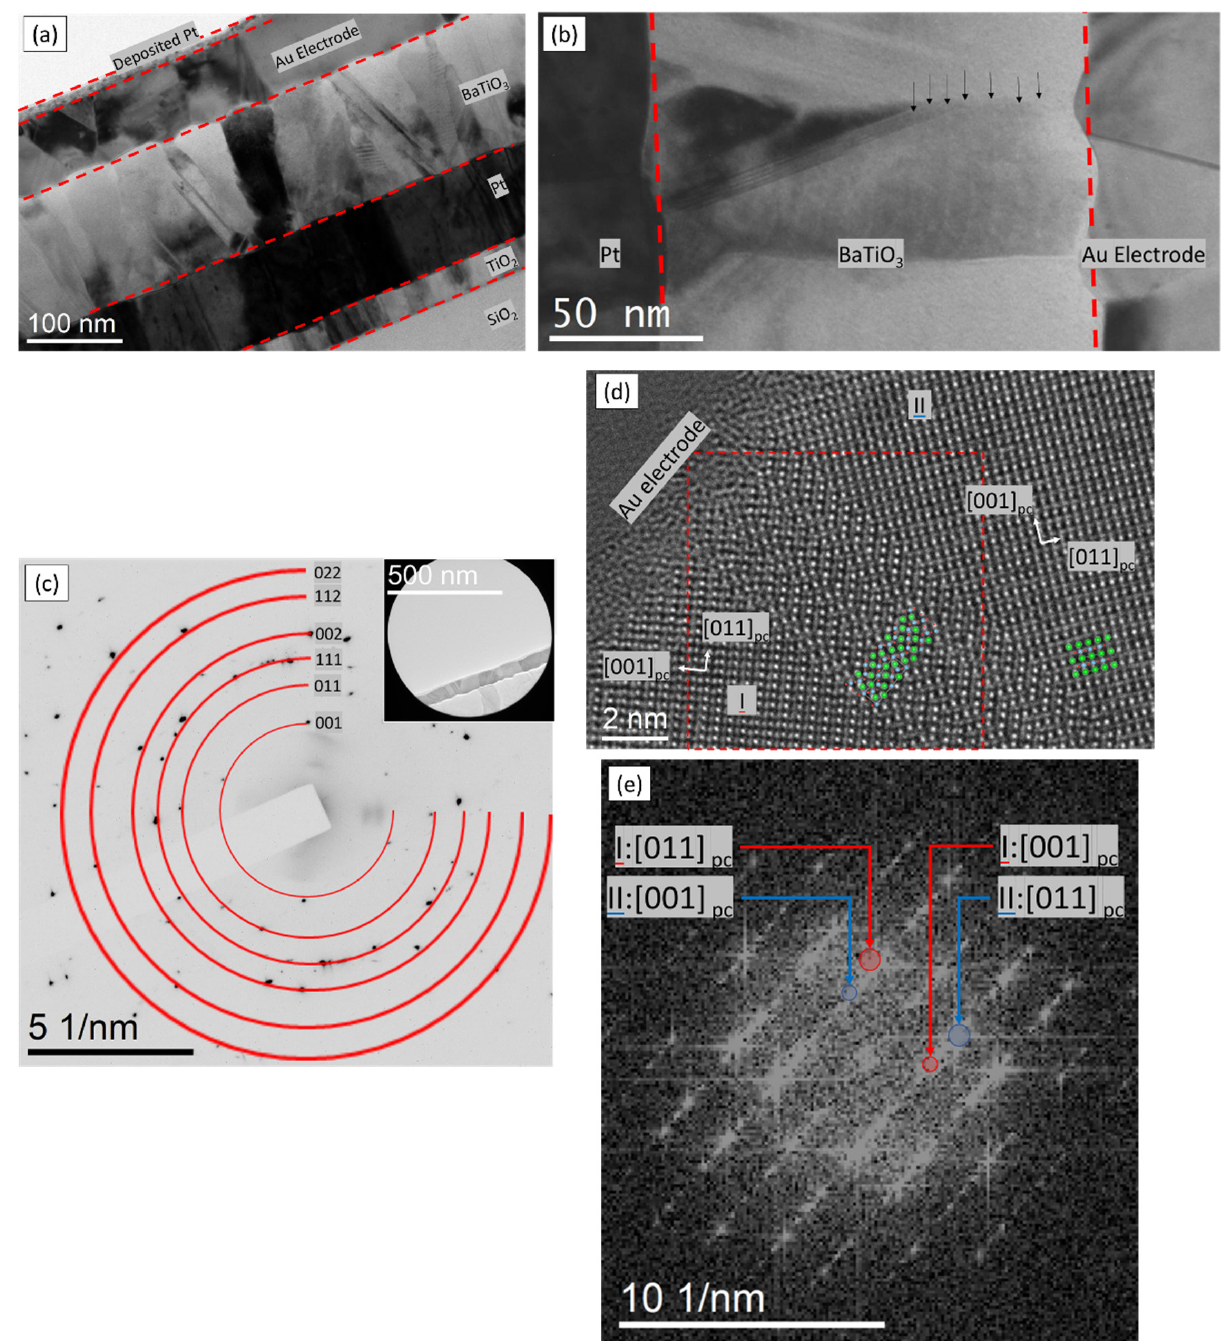
Figure 4. TEM analysis on a BaTiO 3 thin film sample made by FIB lift-out. ( a ) BF image of the general film structure, showcasing also the different substrate layers. ( b ) BF image of a grain of the film, demonstrating that they are columnar; the deposition layers are also evident, their separations are marked with black arrows. ( c ) SADP of the film, the red circles mark the positions matching the diffraction peaks of the BaTiO 3 cubic structure. The inset shows the area selected for diffraction. ( d ) HRTEM of a grain with a [110] zone axis orientation, we can see two variants separated by a hexagonal phase. Overlaids of the hexagonal and cubic BaTiO 3 patterns are displayed to confirm the structure. ( e ) FFT of the red square represented on ( d ).